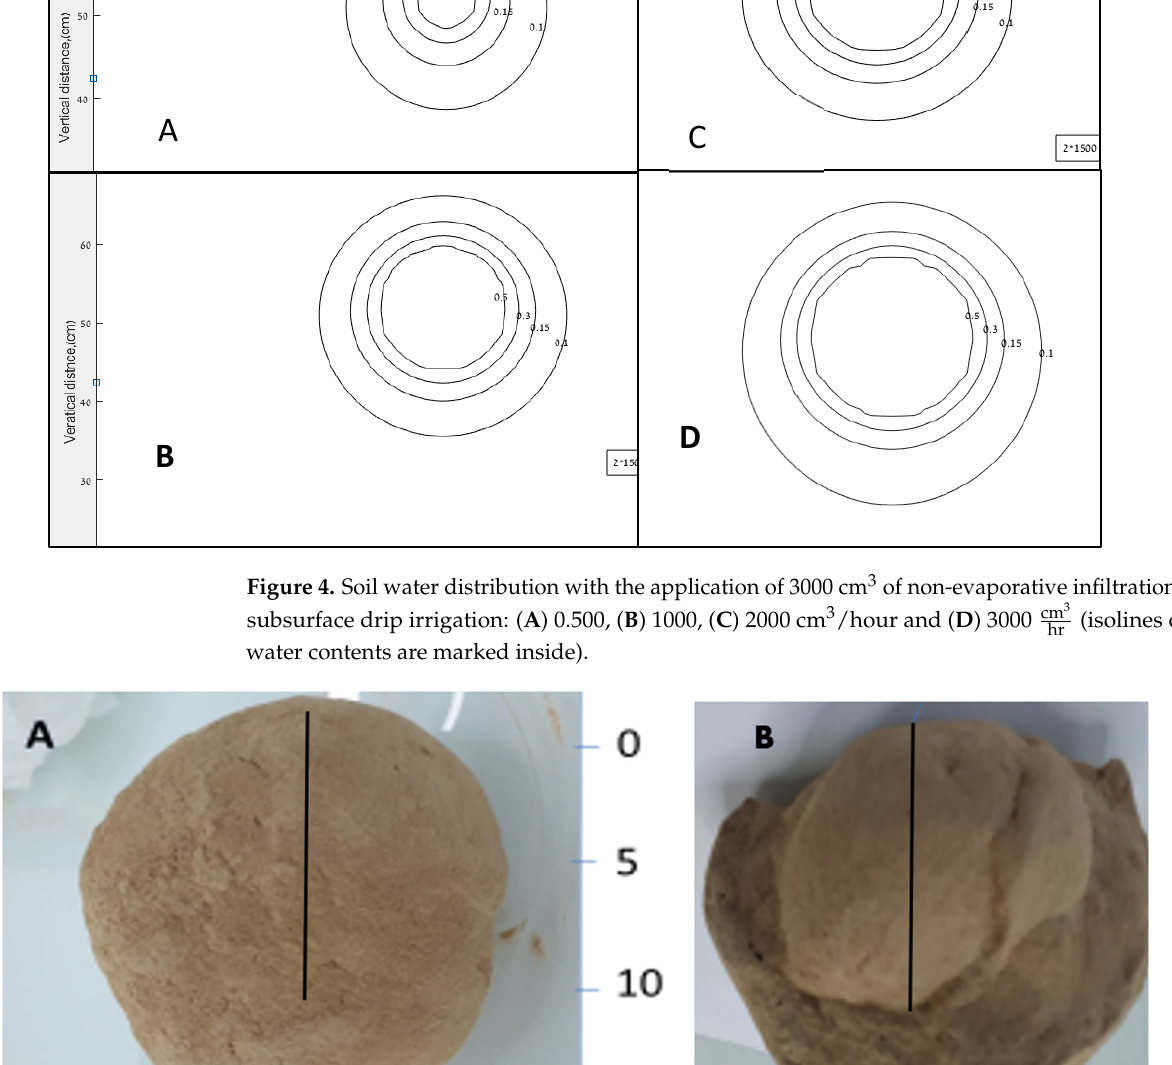
Figure 5. ( A ): Top view of a sphere created by a subsurface drip source inserted into clay loam (loess) ( B ): Internal view of the longitudinal section. The vertical black line marks the borders of the approximate diameter of the saturated sphere. The belt surrounding it resulted from the reduced water content beyond the saturated sphere, as shown in Figure 4A.